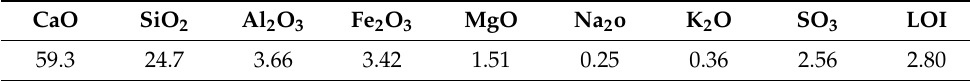
Table 3. The main chemical components of the cement (wt.%).